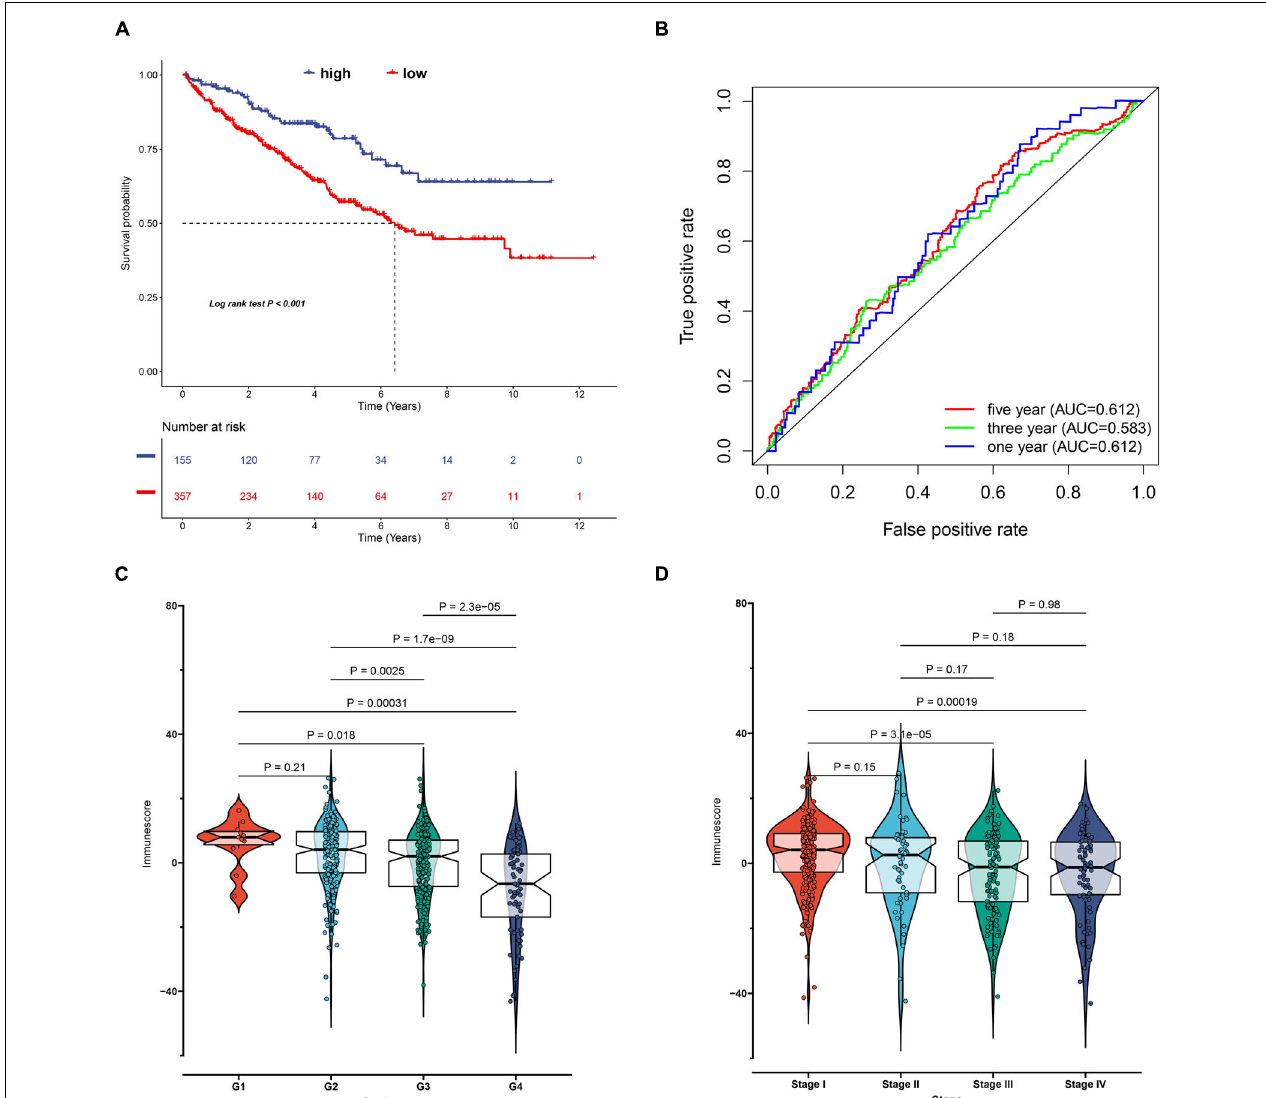
FIGURE 10 | Construction of immune-related (IR) score via principal component analysis. (A) Kaplan–Meier curves for patients with high and low IR score subgroups in TCGA cohort. (B) The receiver operator curve analysis for the IR score. The relationship between IR score and tumor grade (C) and stage (D)